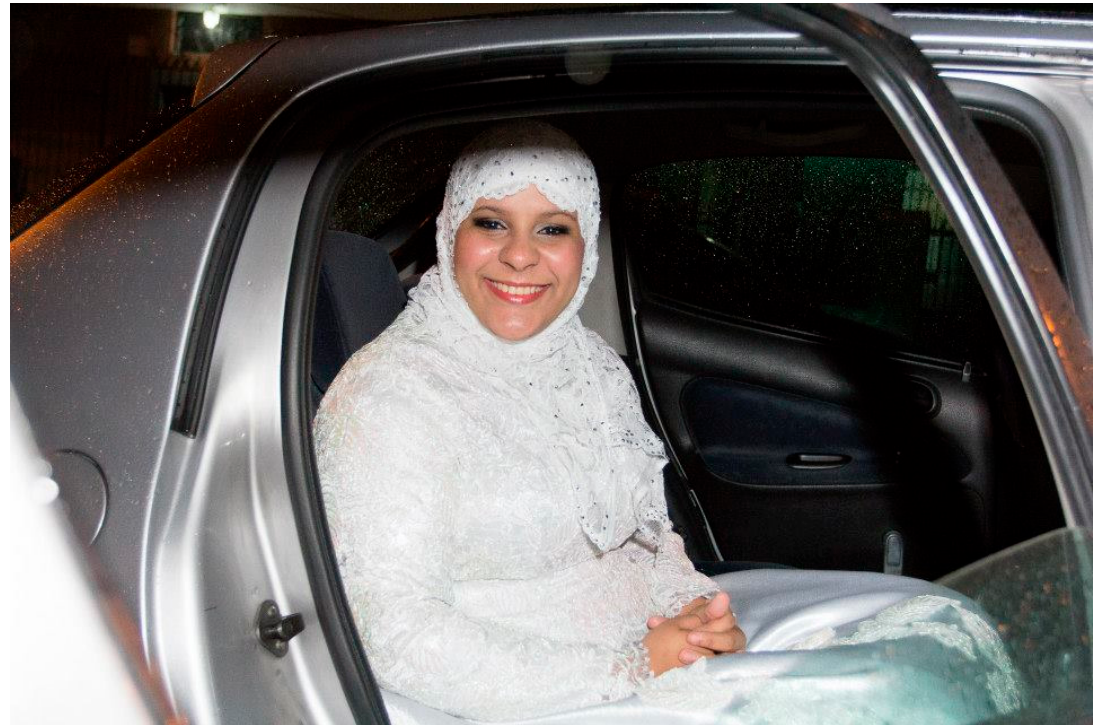
Figure 1. A Brazilian Muslim bride. Photograph courtesy of Petra Duarte. Religions 2019 , 10 , x FOR PEER REVIEW